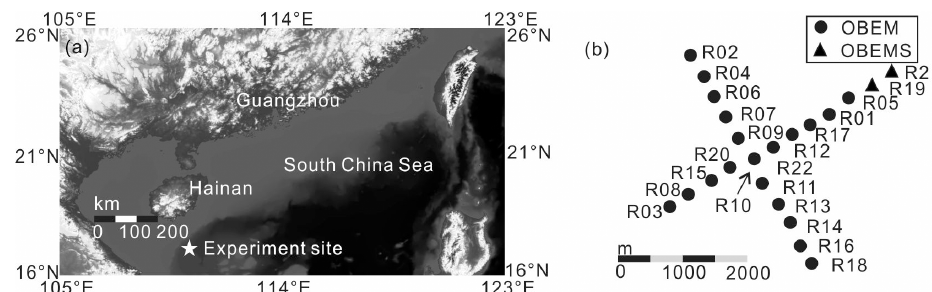
Figure 5. Photograph of the offshore experiment area and site map with all receiver locations marked. The map was generated using the Global Mapper software package.